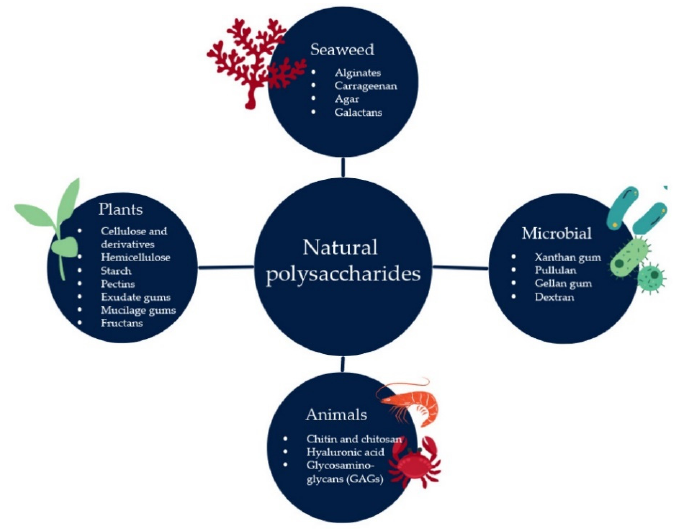
Figure 2. Four main sources of natural polysaccharides.